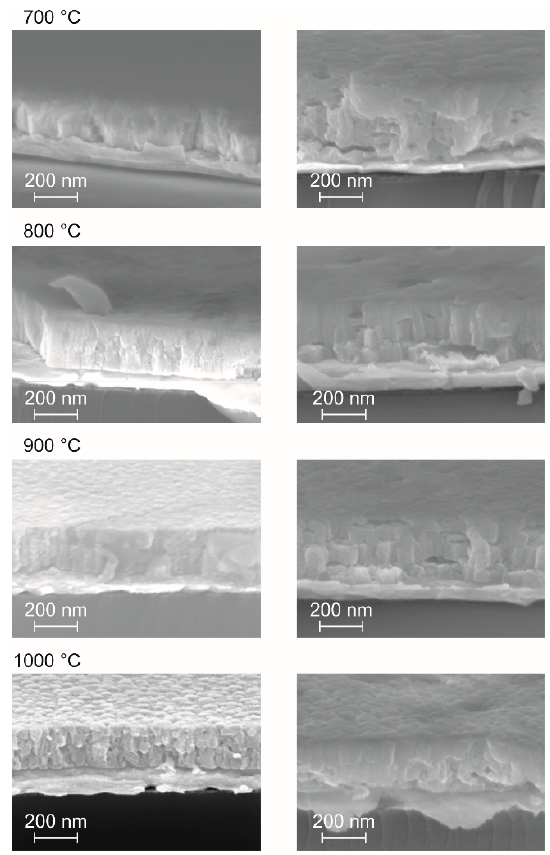
Figure 7. Cross section SEM images from BZY10 films crystallized at different temperatures as indicated. The micrographs shown on the left side stem from five successive coating/annealing cycles of the molecular 0.3 molar con -BZY precursor solution, while the SEM images on the right side were recorded from samples prepared from only three successive coating/annealing cycles of the undiluted µE -BZY dispersion (c = 0.15 mol·L − 1 ).